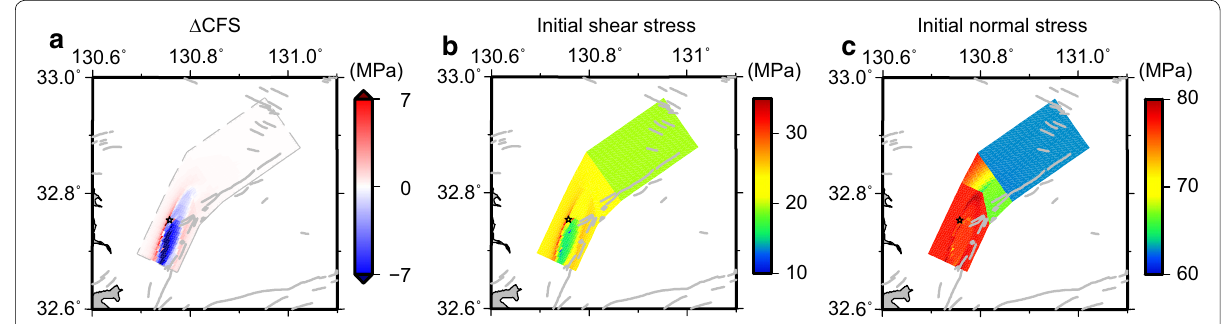
Fig. 5 a Coulomb failure stress change (ΔCFS) due to the three foreshocks, b initial shear stress, and c initial normal stress on a non-planar fault used in dynamic rupture simulations of the main shock. The initial stresses are the sum of the static stress changes due to the three foreshocks and the regional stress field for σ 1 = 100 MPa and σ 3 = 50 MPa . The stars indicate the epicenter of the main shock obtained by Yoshida et al.